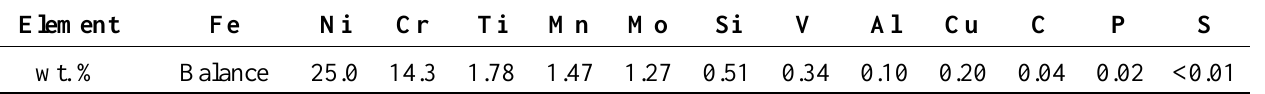
Table 1. Chemical composition of A286 specimens via GDS analysis in wt. %. Element wt.